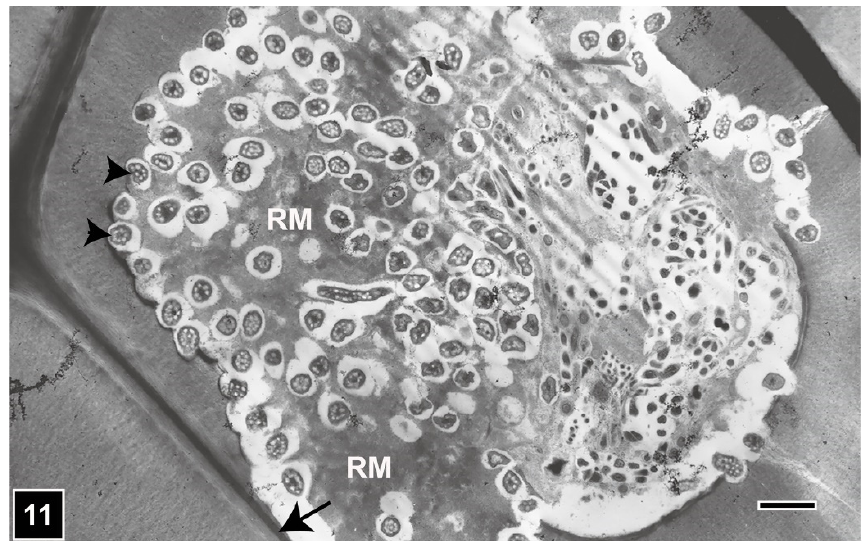
Figure 11. Transverse section through Pinus sylvestris tracheid attacked by erosion bacteria (EB). EB are positioned in vicinity to the secondary cell wall, opposite crescent-shaped erosion troughs (arrowheads). The middle lamella is resistant (arrow). The residual material (RM) is dispersed into the lumen, particularly where the S3 has disappeared. Scale bar = 4 µm. The image is reproduced from Singh et al. (2016) Secondary Xylem Biology.